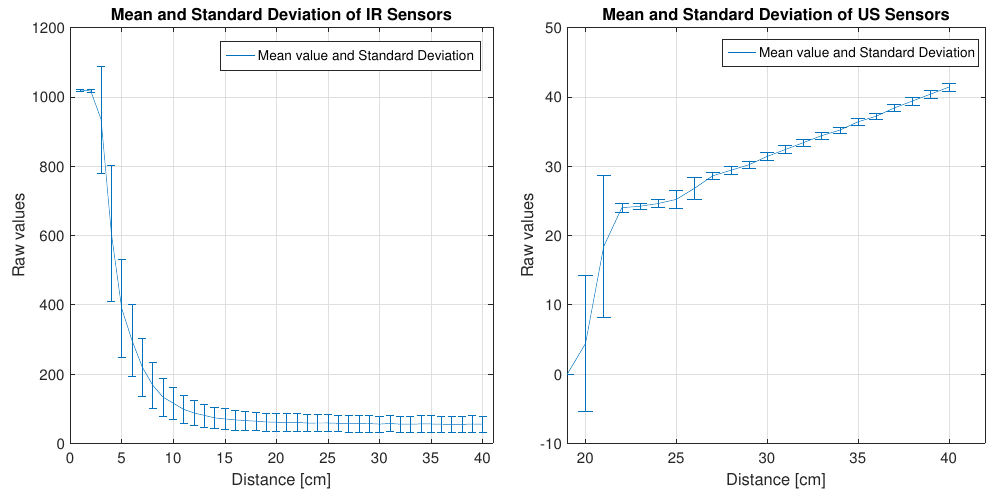
Figure 6. Mean and Standard Deviation of the IR and US sensors of Robot